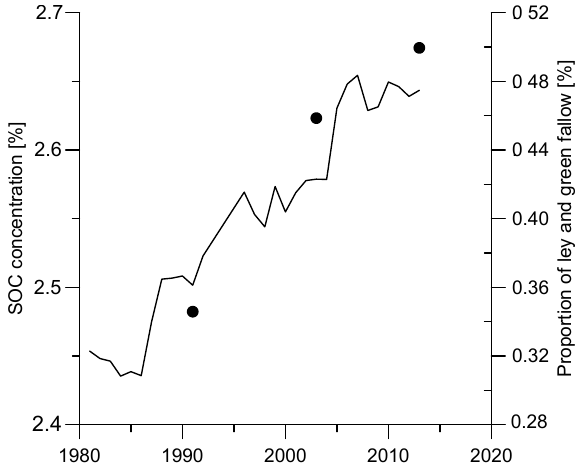
Figure 4. Country-average carbon concentrations for Inventories I– III and trends in ley and green fallow as a proportion of total agri- cultural